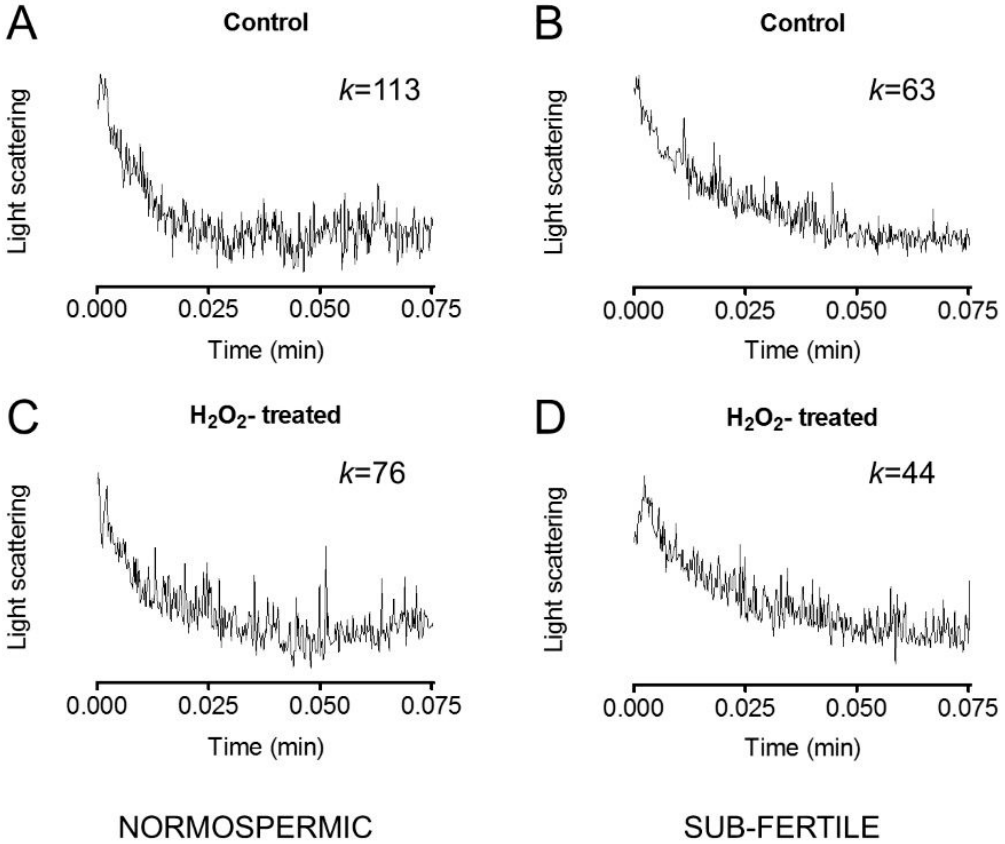
Figure 3. Representative traces of stopped-flow osmotic water permeability measurements obtained from human ejaculated semen of normospermic ( A , C ) and sub-fertile ( B , D ) subjects. Sperm cells were exposed to a 150 mOsm osmotic gradient in two different conditions: untreated cells (Control; ( A , B )) and cells treated for 45 min with 50 μ M H 2 O 2 to induce an oxidative stress condition (H 2 O 2 -treated; ( C , D )). k relative values of single curves are also shown.